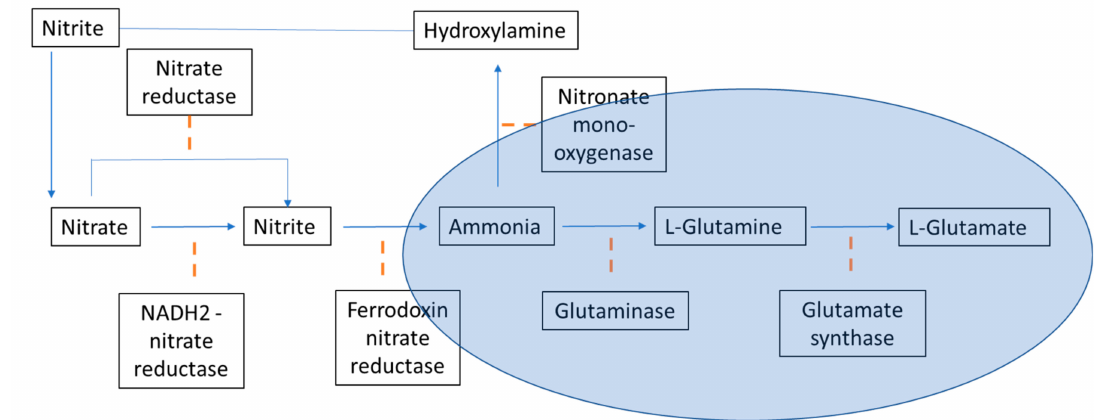
Figure 9. Nitrogen metabolism reduction and fixation in photosynthetic organisms. The blue oval depicts the pathway that has been used by microalgae in order to acquire N directly from